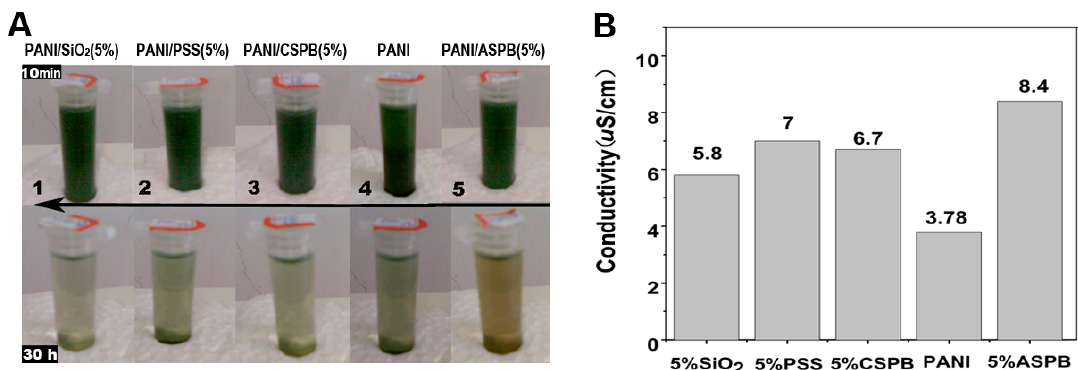
Figure 6. ( A ) Qualitative and ( B ) quantitative analysis of the conductivity of saturated solution of PANI, PANI/ASPB, PANI/PSS, PANI/CSPB, and PANI/SiO 2 nanocomposites ( T = 25 °C, pH = 6).